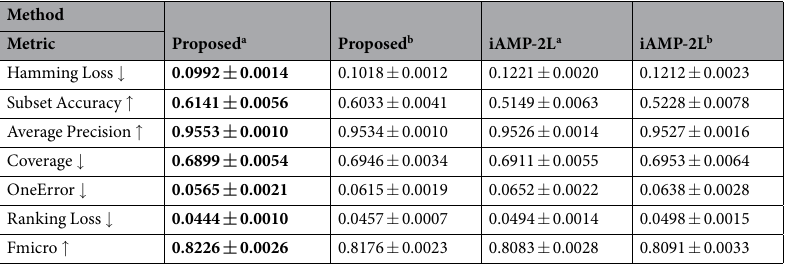
Table 9. The means and standard deviations of 5-CV results with the proposed method and iAMP-2L when testing on the filtered dataset. The superscript a indicates the feature extraction method in this work, and b indicates the PseAAC. ↓ means lower is better; ↑ means higher is better. The best value for each metric is in